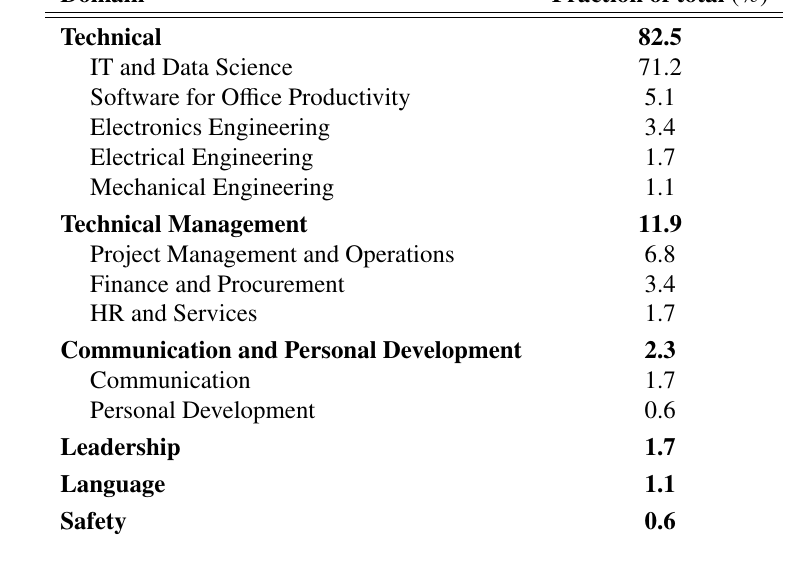
Table 2. Usage of Udemy for CERN licences by